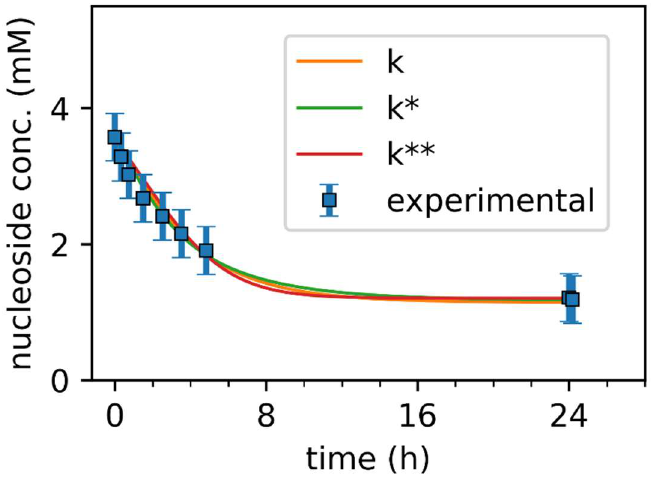
Figure 4. Non-identifiability of parameter sets from given experimental data. Experimental data (blue squares) and simulation of parameter sets k, k*, and k**, for a given experimental condition. The modelled results from different parameter sets are almost indiscernible, and, therefore, no decision can be taken on which parameter set is correct.